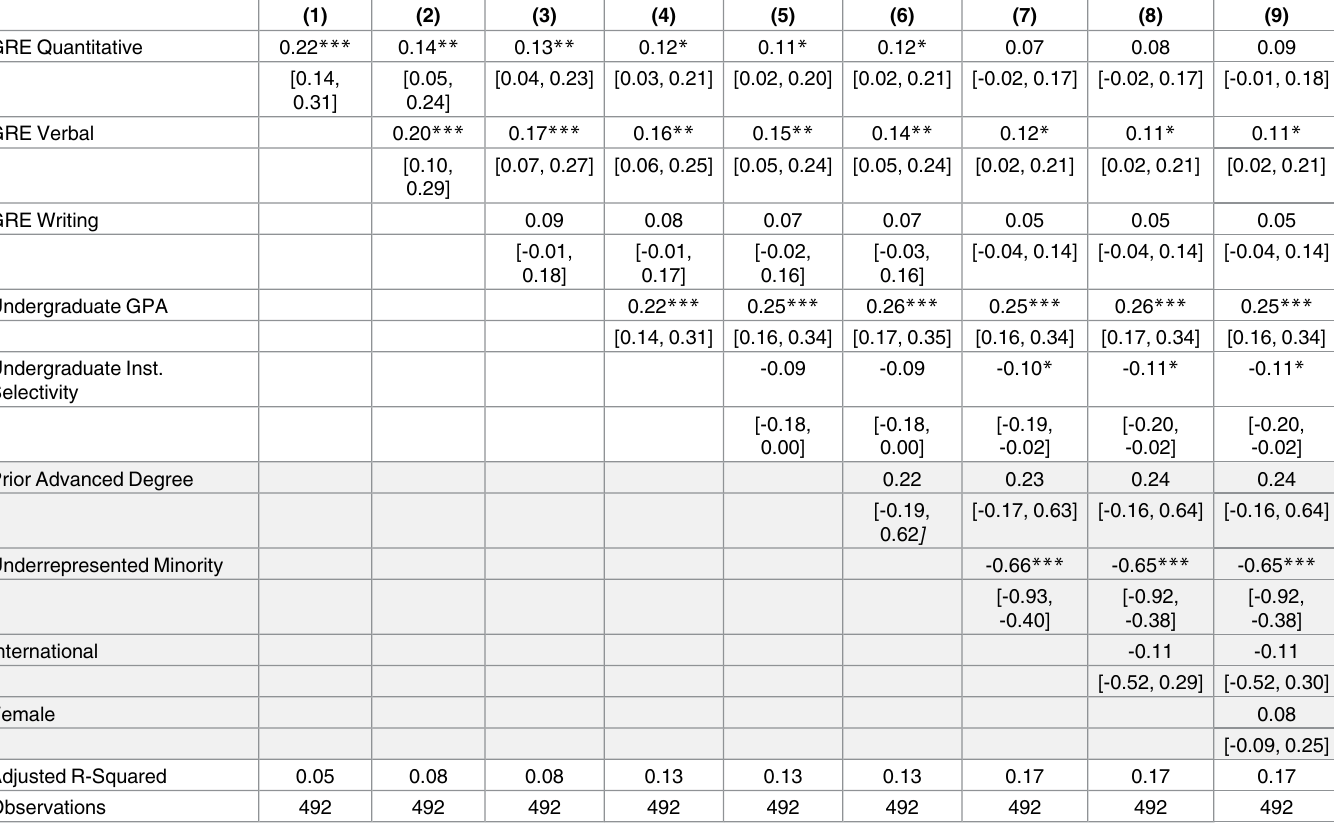
Standardized regression coefficients and 95% confidence intervals are reported for continuous variables. Coefficients on the binary variables are shaded gray and report the standard deviation change in the outcome by moving from 0 to 1 on the binary variable. Cohort fixed effects are included for each model. Adjusted R-squared is presented for each